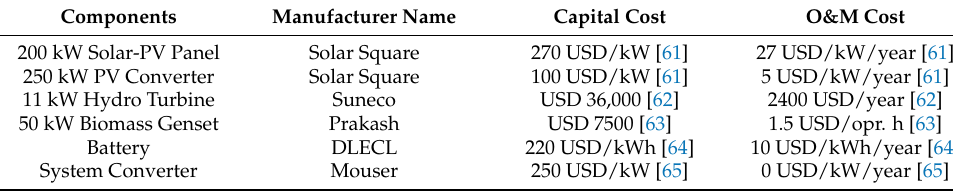
Table 2. Price considered for different components as used in designing an IES.